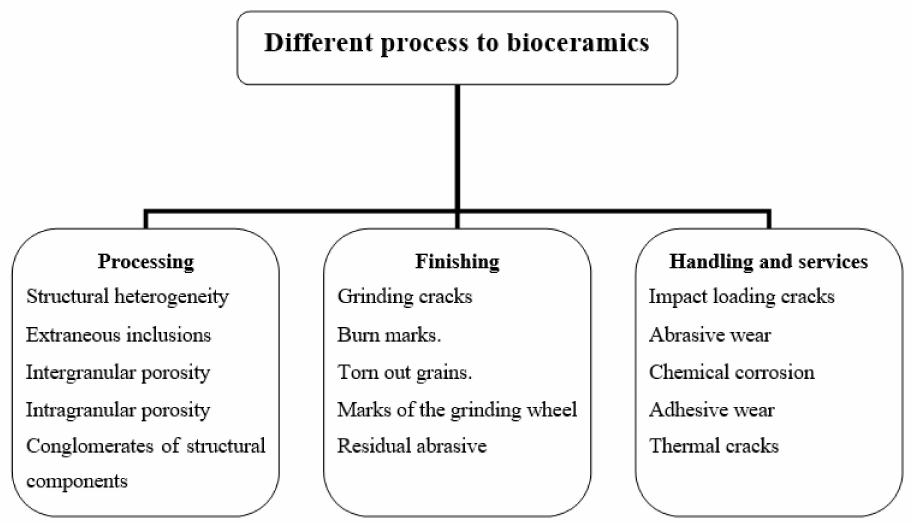
Figure 3. Different types of processing-derived defects in